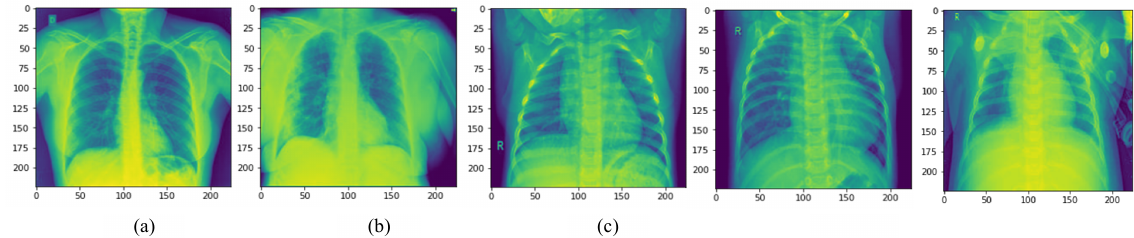
Fig. 6 The conversion result from chest x-ray (CXR), with images (a) Mild COVID (b) Severe COVID (c) COVID Normal (d) Mild pneumonia (e) Severe pneumonia